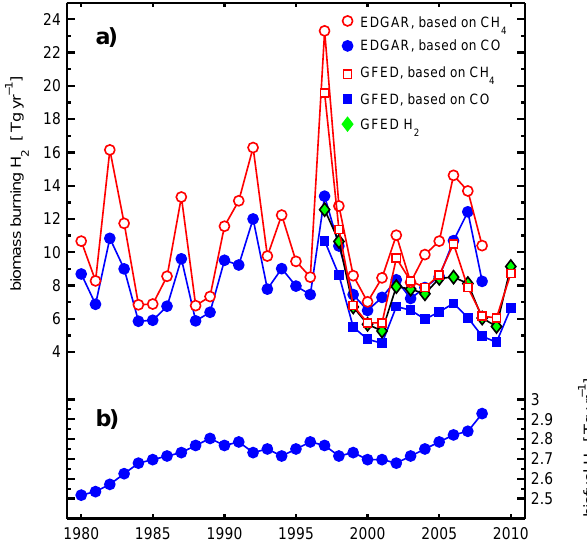
Fig. 5. Global molecular hydrogen (H 2 ) emissions from biomass burning (a) and domestic emissions ( b , with finer y-axis resolution) using emission inventories from the Emission Database For Global Atmospheric Research (EDGARv4.2) project (Olivier et al., 2002), and the Global Fire Emissions Database version 3 (GFED3, data set at http://www.globalfiredata.org/, see also Giglio et al., 2010 and van der Werf et al., 2010). The carbon monoxide (CO) emission inventories were converted to H 2 using a molar H 2 /CO ratio of 0.25, and the methane (CH 4 ) emission inventories were converted to H 2 using a molar H 2 /CH 4 ratio of 3.6 (see text). GFED3 H 2 and CH 4 - derived H 2 emissions agree well, while CO-derived H 2 emissions are considerably lower. EDGAR emissions are generally larger than GFED3